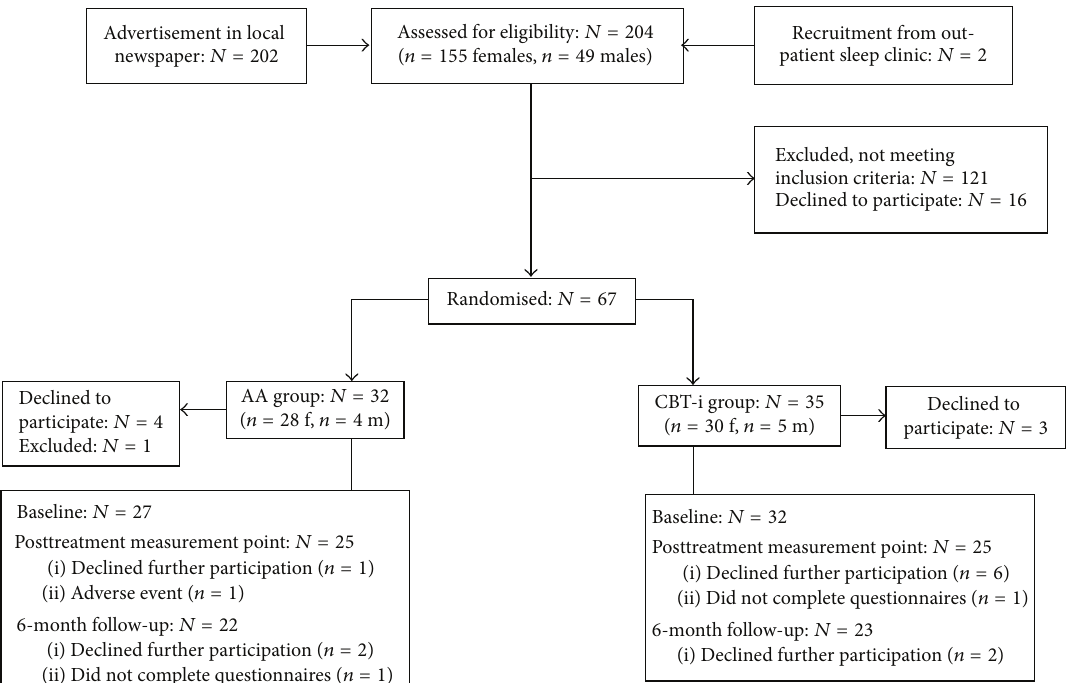
Figure 2: Participant flow diagram and passage of events during the